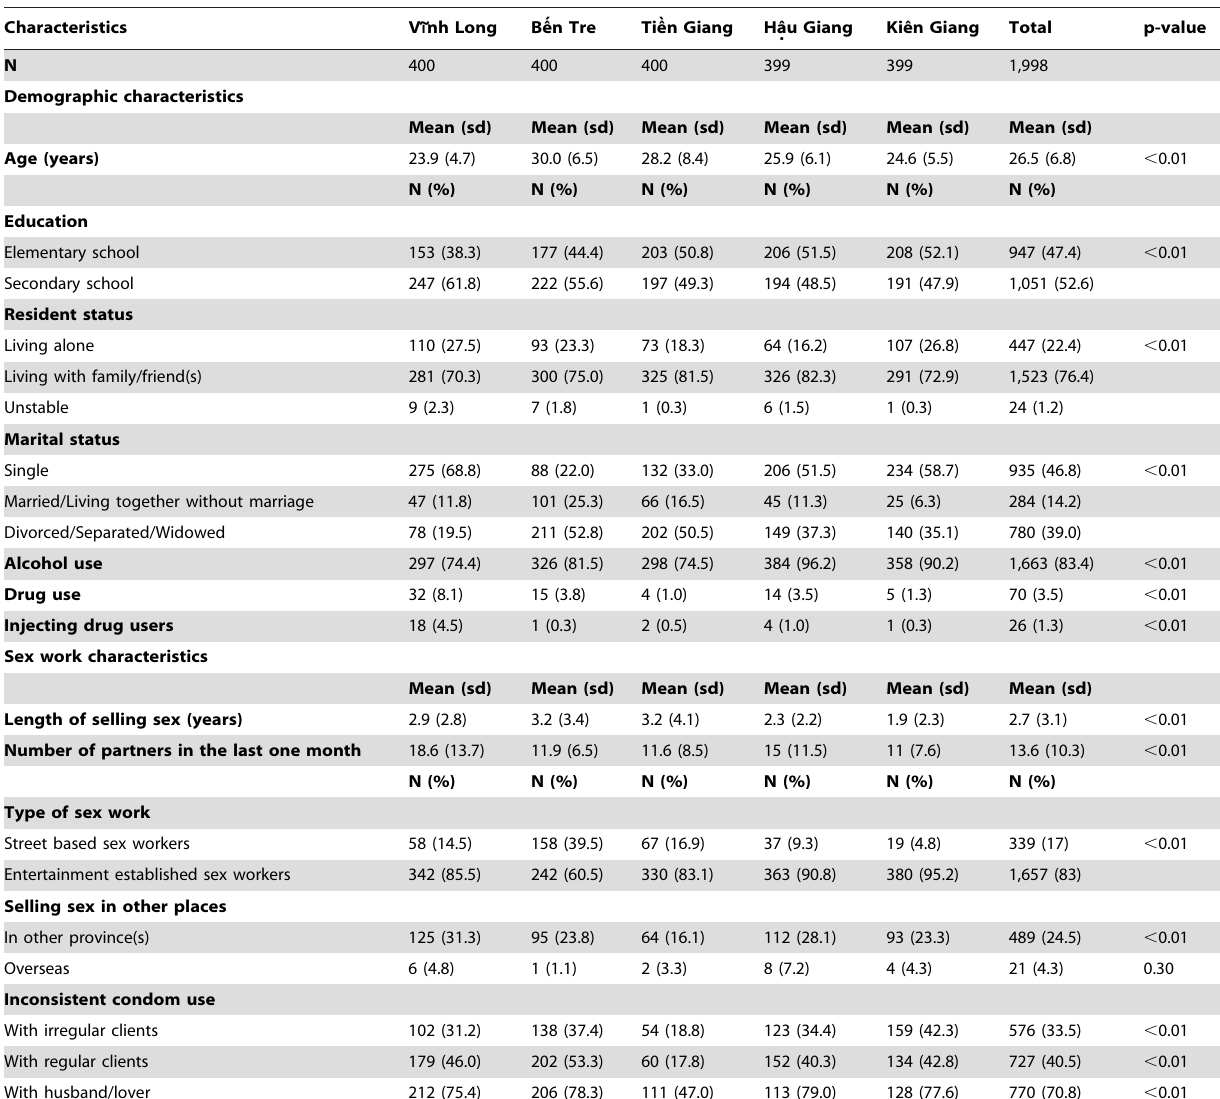
Table 1. Demographic and sex work characteristics among study participants.